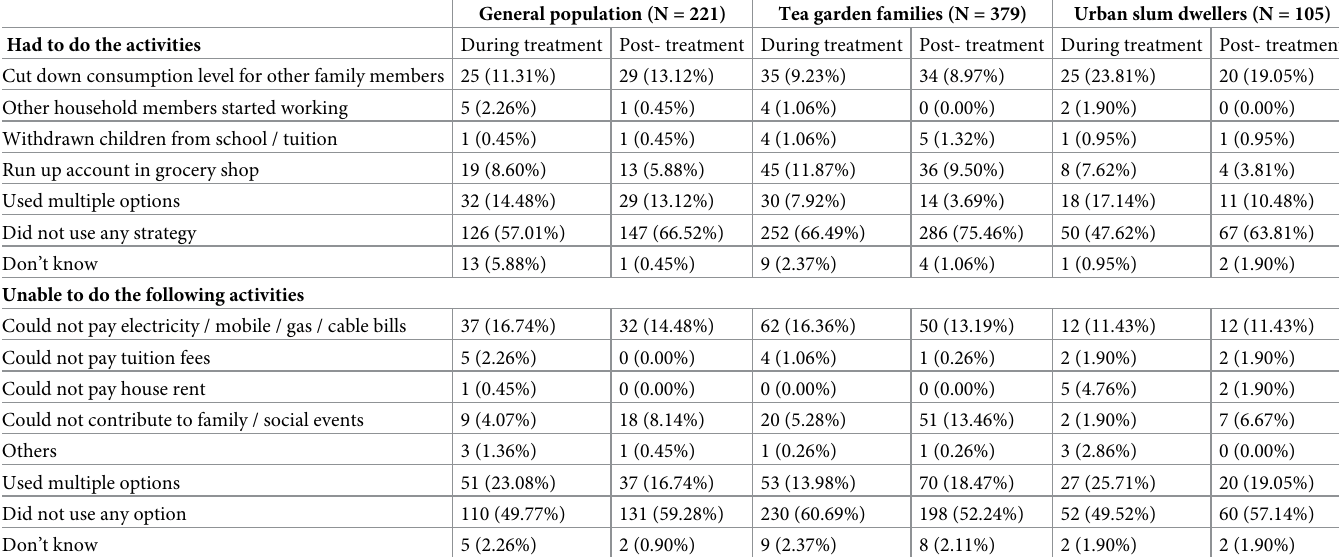
Table 6. Other economic consequences on sampled tuberculosis